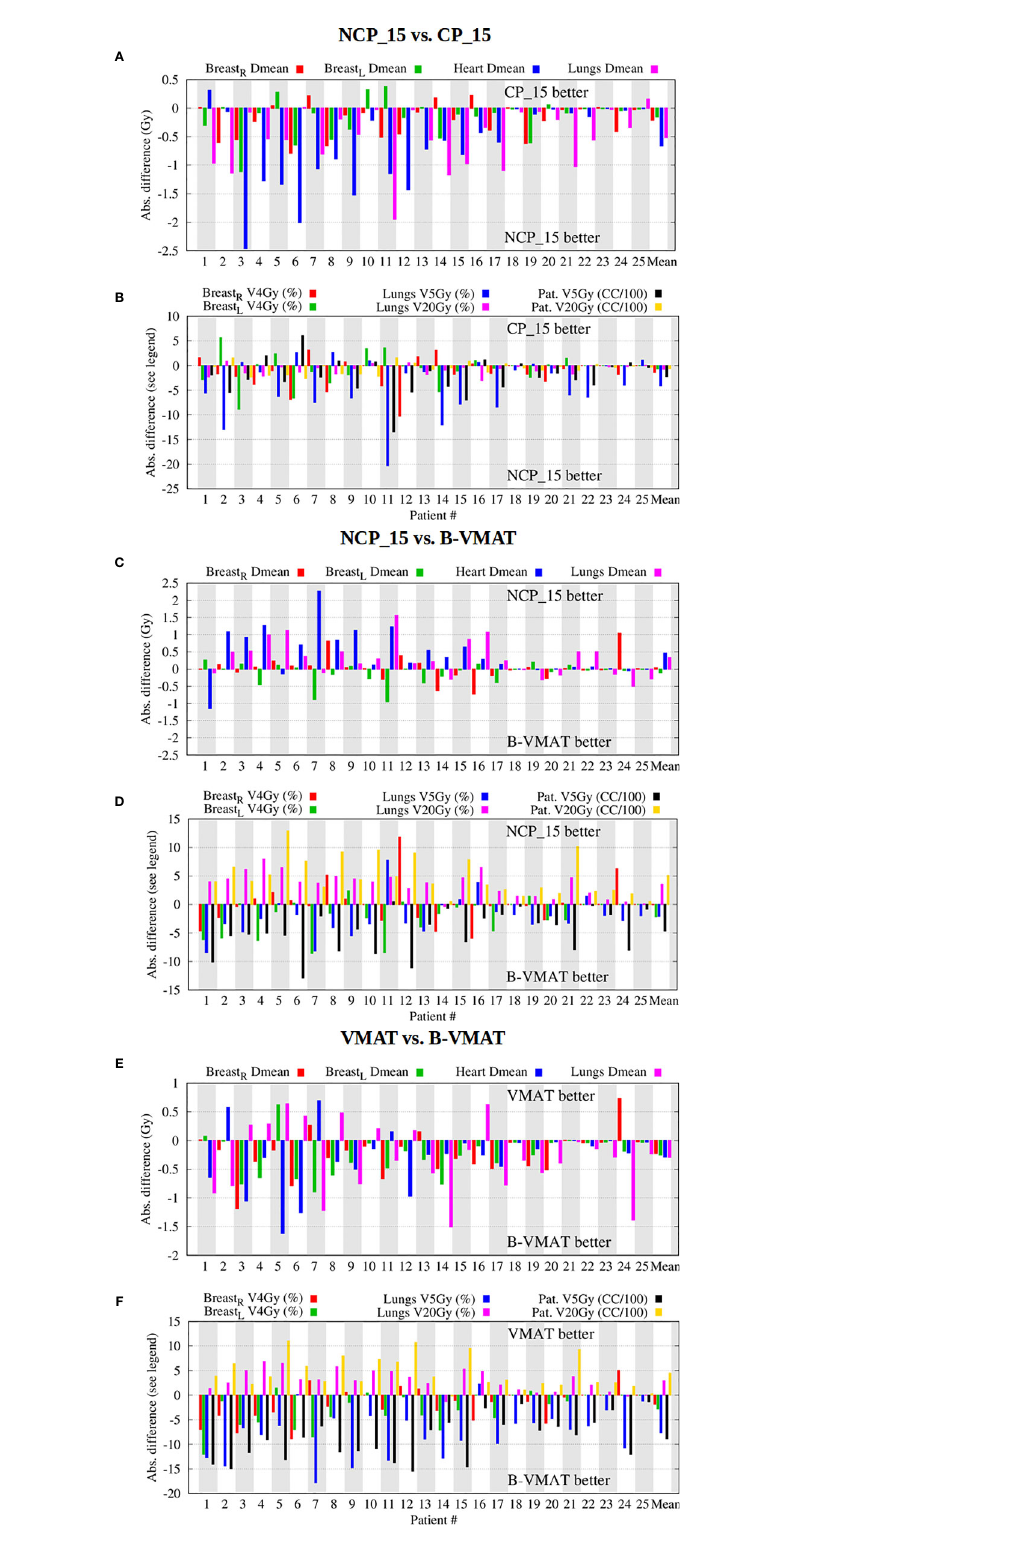
FIGURE 4 | Beam con fi guration comparisons - NCP_15 vs. CP_15 (A, B) , NCP_15 vs. B-VMAT (C, D) , and VMAT vs. B-VMAT (E, F) - showing large inter-patient and inter-parameter variations in differences in plan parameter values. Patients were ordered according to descending heart Dmean in the NCP_15